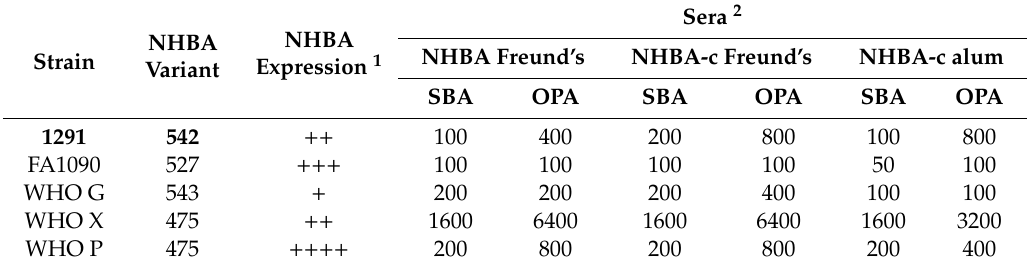
Table 2. Serum bactericidal and opsonophagocytic titers of NHBA and NHBA-c mouse sera against five gonococcal strains.